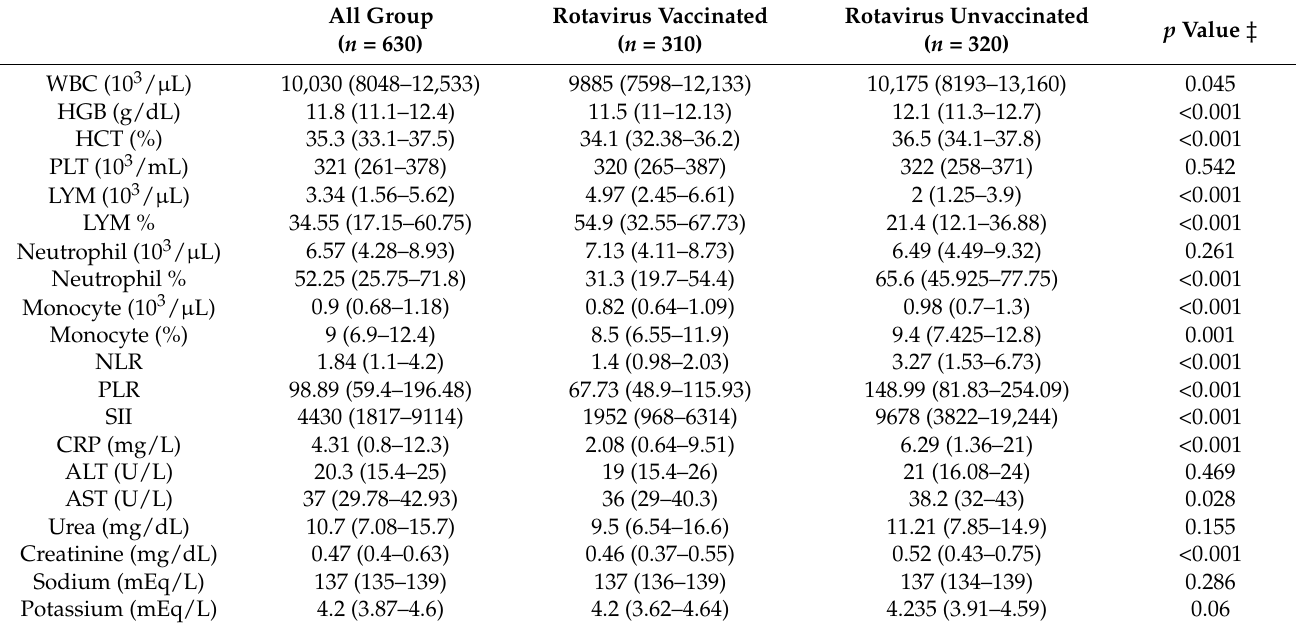
Table 2. Laboratory findings of vaccinated and unvaccinated patients with rotavirus